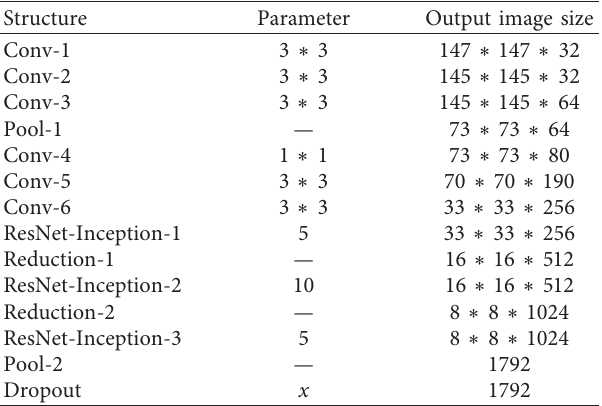
Table 1: Basic parameters of ResNet-Inception network structure.